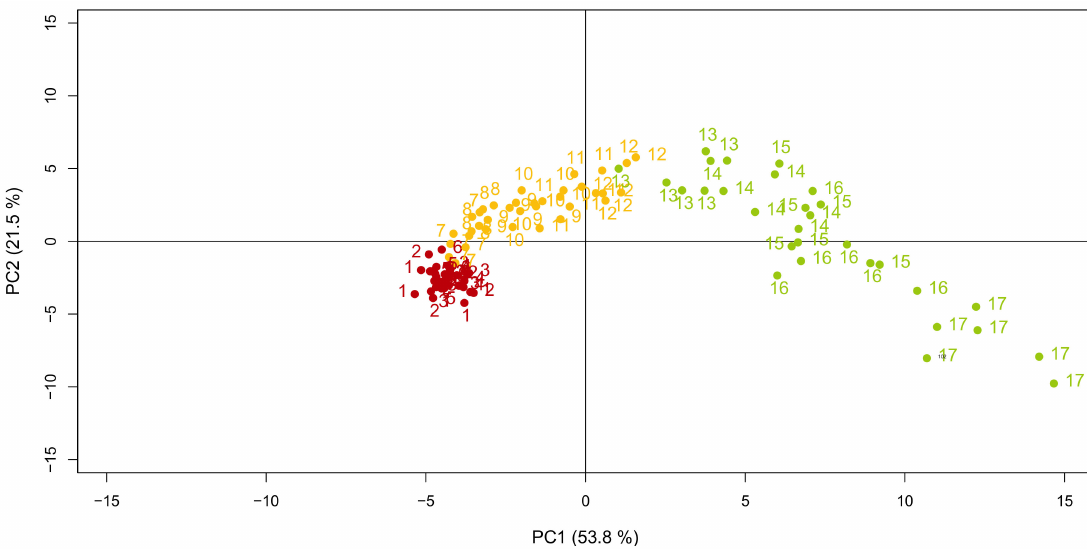
Figure 2. Principal component analysis (PCA) showing the distribution of flax leaves based on their metabolic content. The samples are identified as follows: 1: leaves 3–4; 2: leaves 7–8; 3: leaves 11–12; 4: leaves 15–16; 5: leaves 19–20; 6: leaves 23–24; 7: leaves 27–28; 8: leaves 31–32; 9: leaves 35–36; 10: leaves 39–40; 11: leaves 43–44; 12: leaves 47–48; 13: leaves 51–52; 14: leaves 55–56; 15: leaves 57–58; 16: leaves 59–60; 17: apical bunch of leaves, from leaf 61. The samples are di ff erently coloured whether they belong to the mature (red), the transition (yellow), or the young (green) populations of leaves, as defined in Figure 1. For every leaf sample, n =